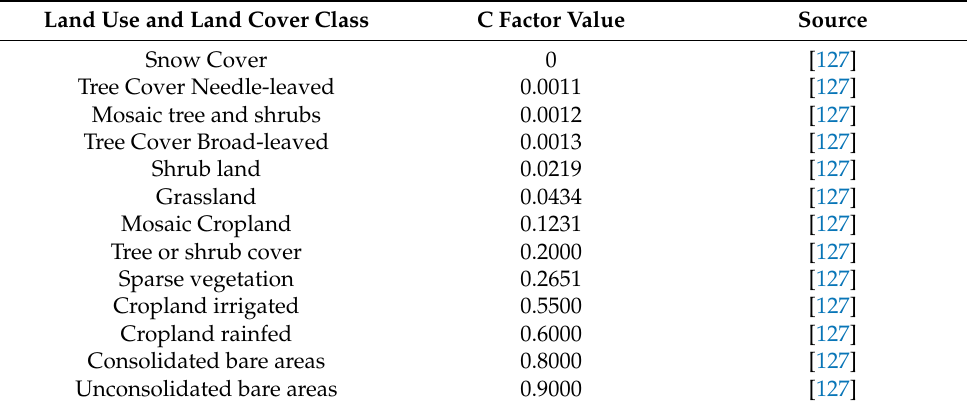
Table 2. Cover management factor values of the Chenab river catchment. Land Use and Land Cover Class